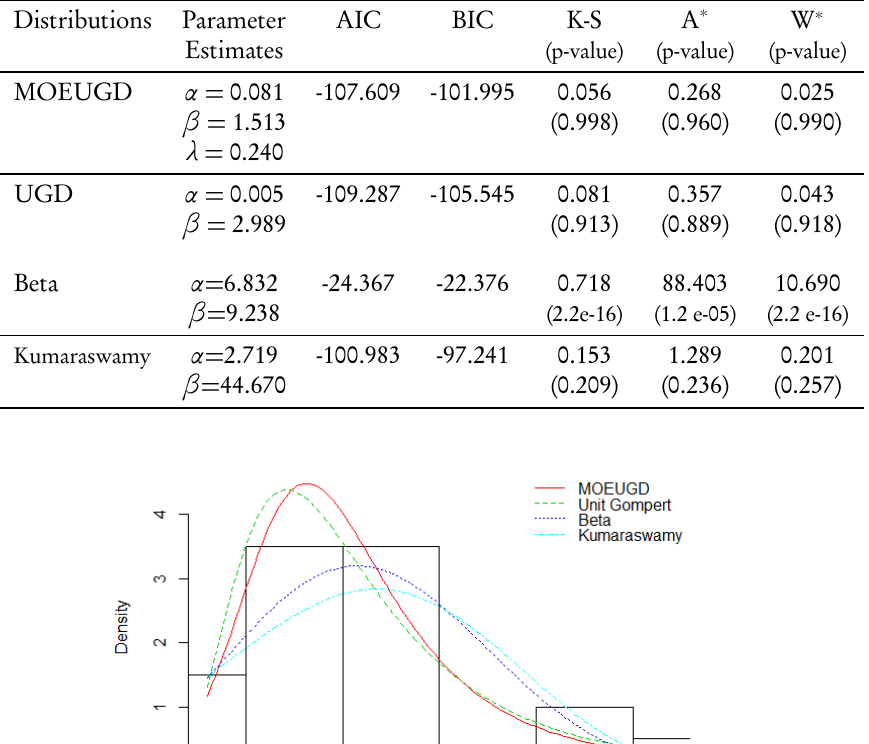
Summary Statistics for the Rock Samples from a Petroleum Reservoir Data Set, n = 48.